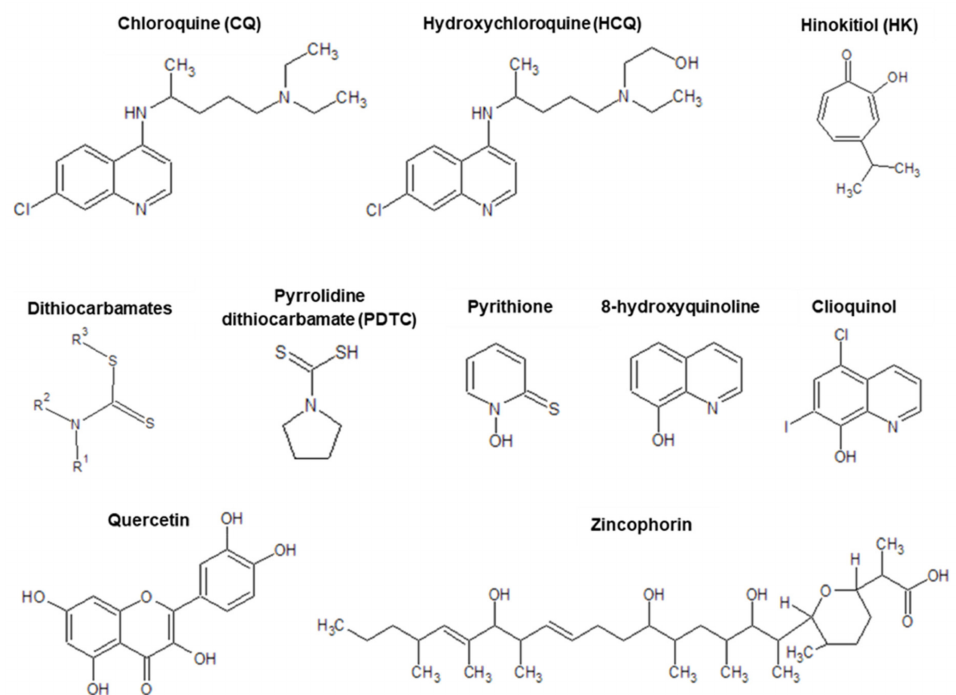
An overview of zinc(II) ionophores discussed in this work: chloroquine (CQ), hydroxychloroquine (HCQ), hinokitol (HK), dithiocarbamates (DTCs), pyrrolidine dithiocarbamate (PDTC), pyrithione (PT), 8-hydroxyquinoline (PBT2), clioquinol, quercetin and